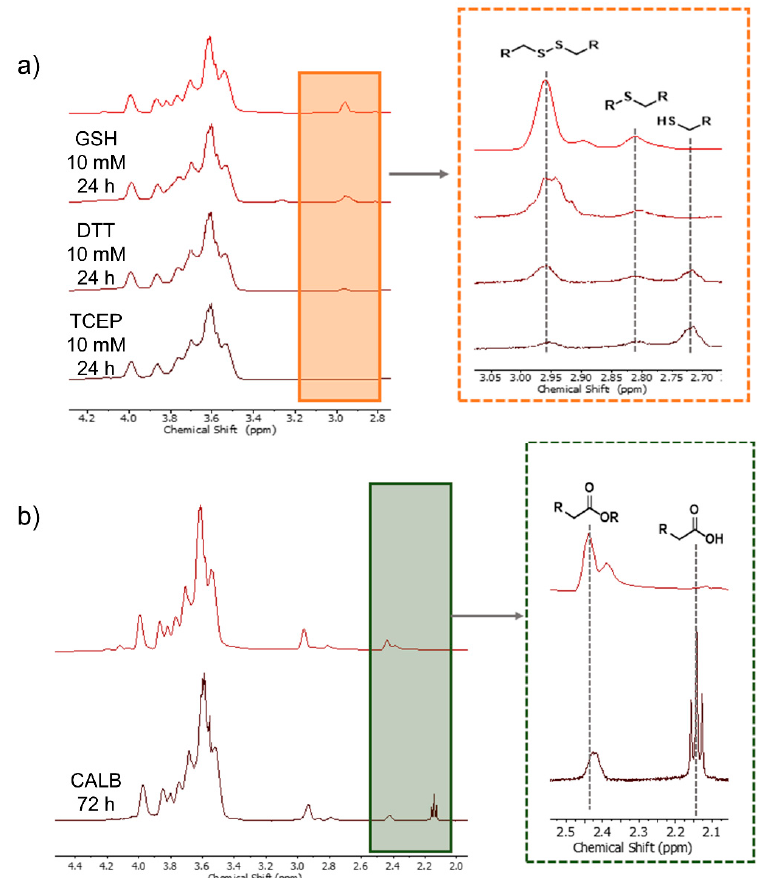
Figure 3. Degradation Study of DR-dPG. ( a ) 1 H NMR spectra after 24 h with incubation at reductive conditions with GSH, DTT, and TCEP. The decrease in the integral of methylene group next to the disulfide and increase in its thiol counterpart are highlighted; ( b ) degradation under enzymatic conditions with CALB. The decrease in the methylene bridge in α -position to the ester and increase in its respective acid counterpart are